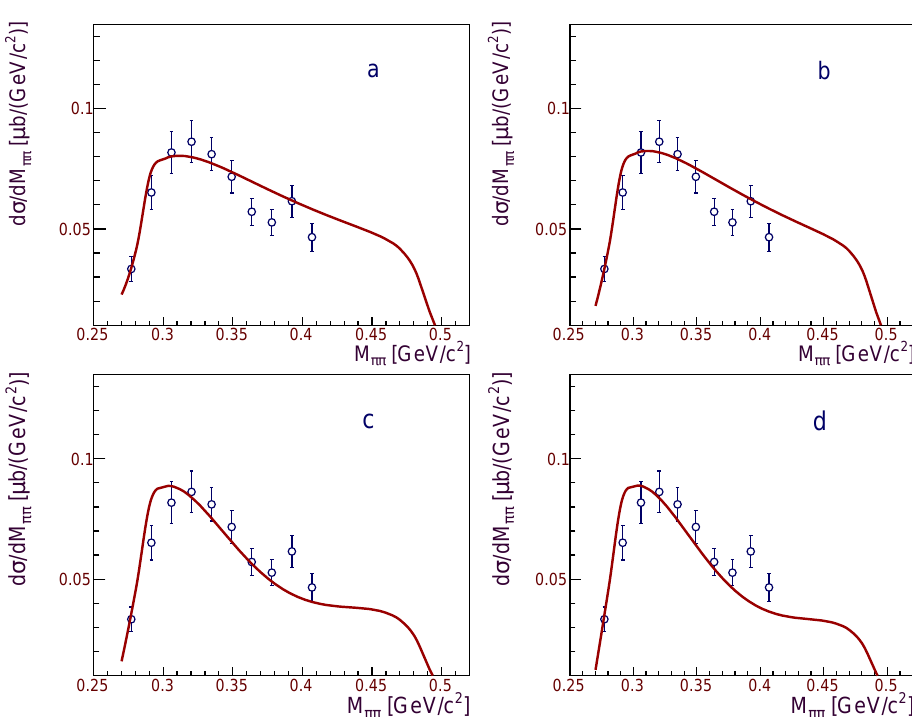
Figure 4: The same as in Fig. 3 but with the model calculations at the scattering angle θ c . m . of final deuteron in the interval 0 ◦ < θ c . m . d